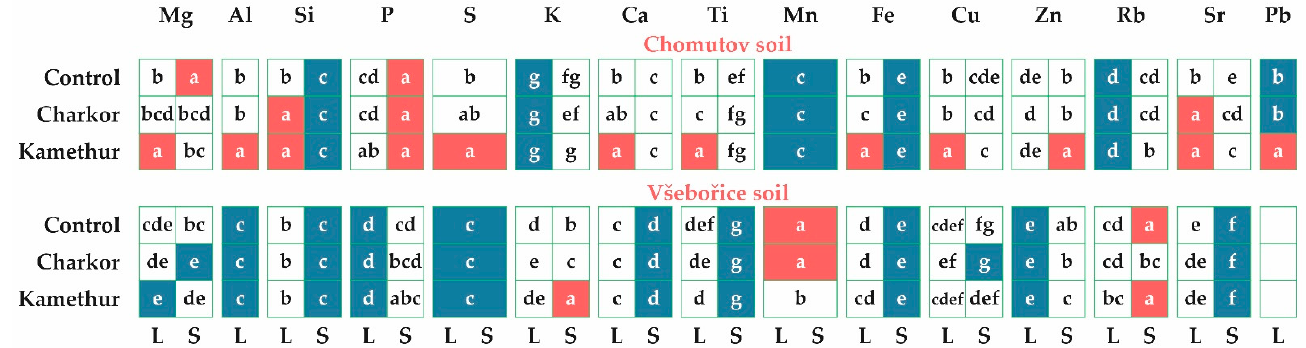
Figure 4. Leaves and stem’s DW of M×g grown in the Chomutov and Všebo ř ice soils. Different let- ters indicate a significant difference between the values ( p < 0.001).